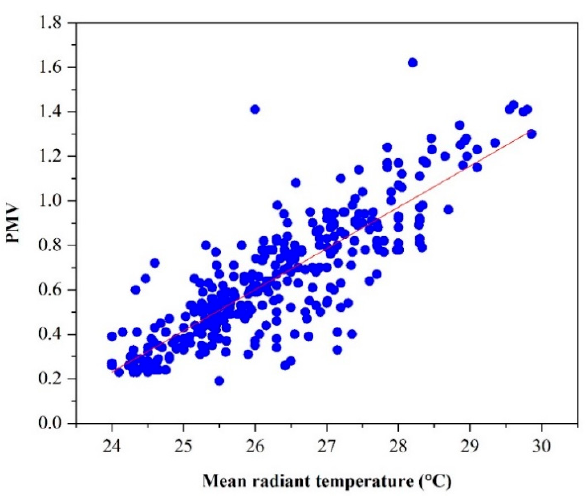
Figure 11. Relationship between predicted mean vote (PMV) and mean radiant temperature (T r ).